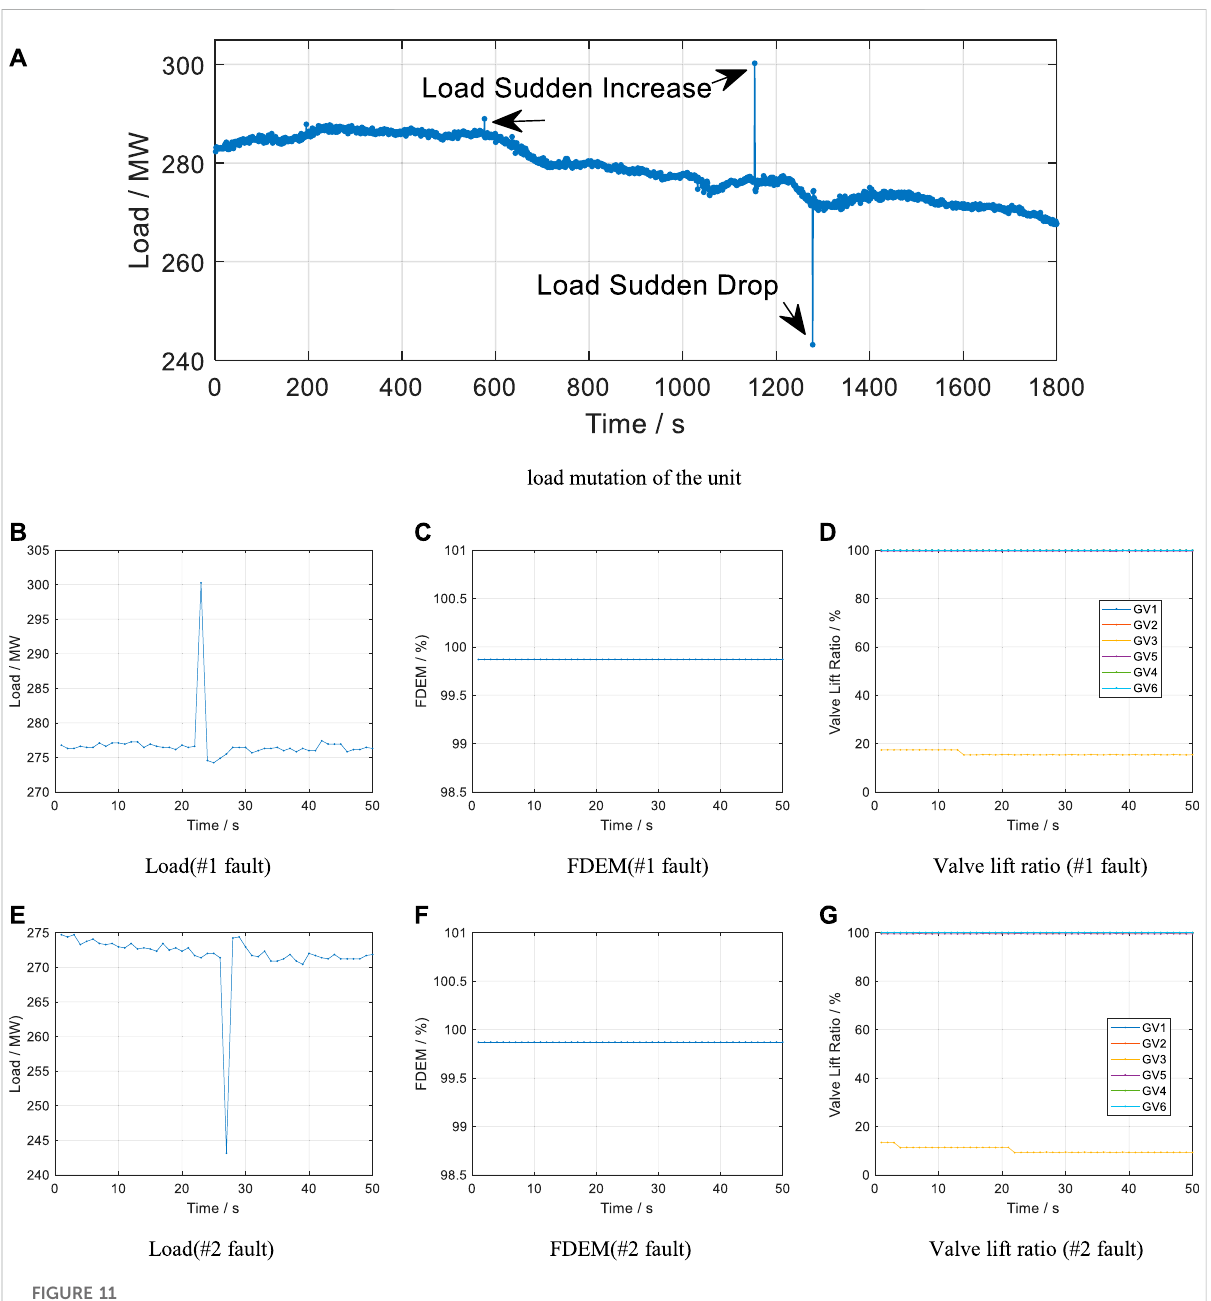
FIGURE 11 Loadmutationcausedbyasensorfault. (A) Loadmutationoftheunit. (B) Load(#1fault). (C) FDEM(#1fault). (D) Valveliftratio(#1fault). (E) Load (#2 fault). (F) FDEM (#2 fault). (G) Valve lift ratio (#2